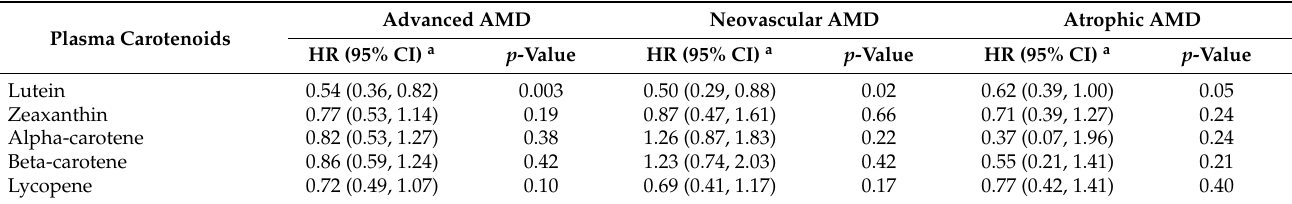
Table 5. Associations between plasma carotenoids and carotenoids/(TC + TG) ratios and incidence of advanced AMD: sensitivity analyses adjusted for dietary intakes. Alienor scheme